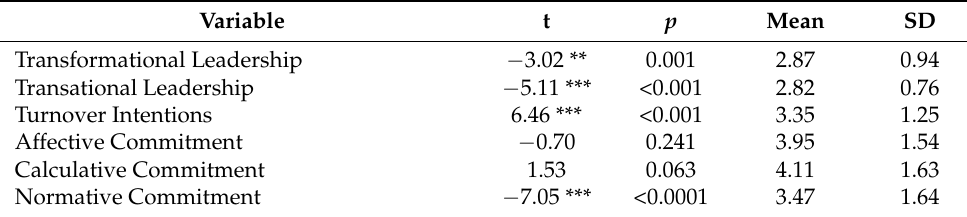
Table 2. Descriptive Statistics of the Variables under Study.